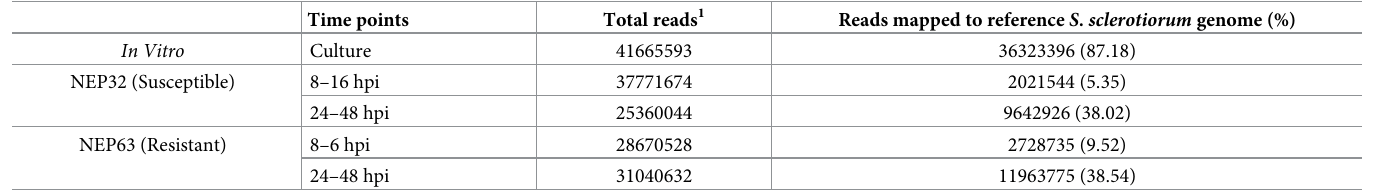
Table 1. Summary of the Illumina sequence reads obtained from Brassica napus plant inoculated with S . sclerotiorum and from mycelium of S . sclerotiorum isolate 1980 grown on potato dextrose agar. Time